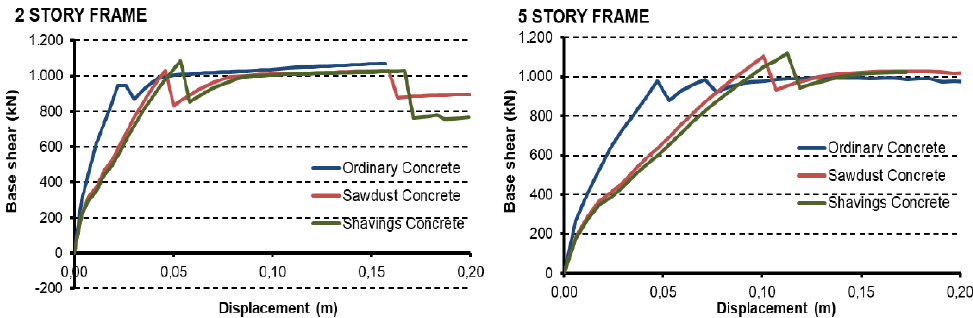
Figure 9. Capacity curves: ( left ) 2-storey frame; ( right ) 5-storey frame.